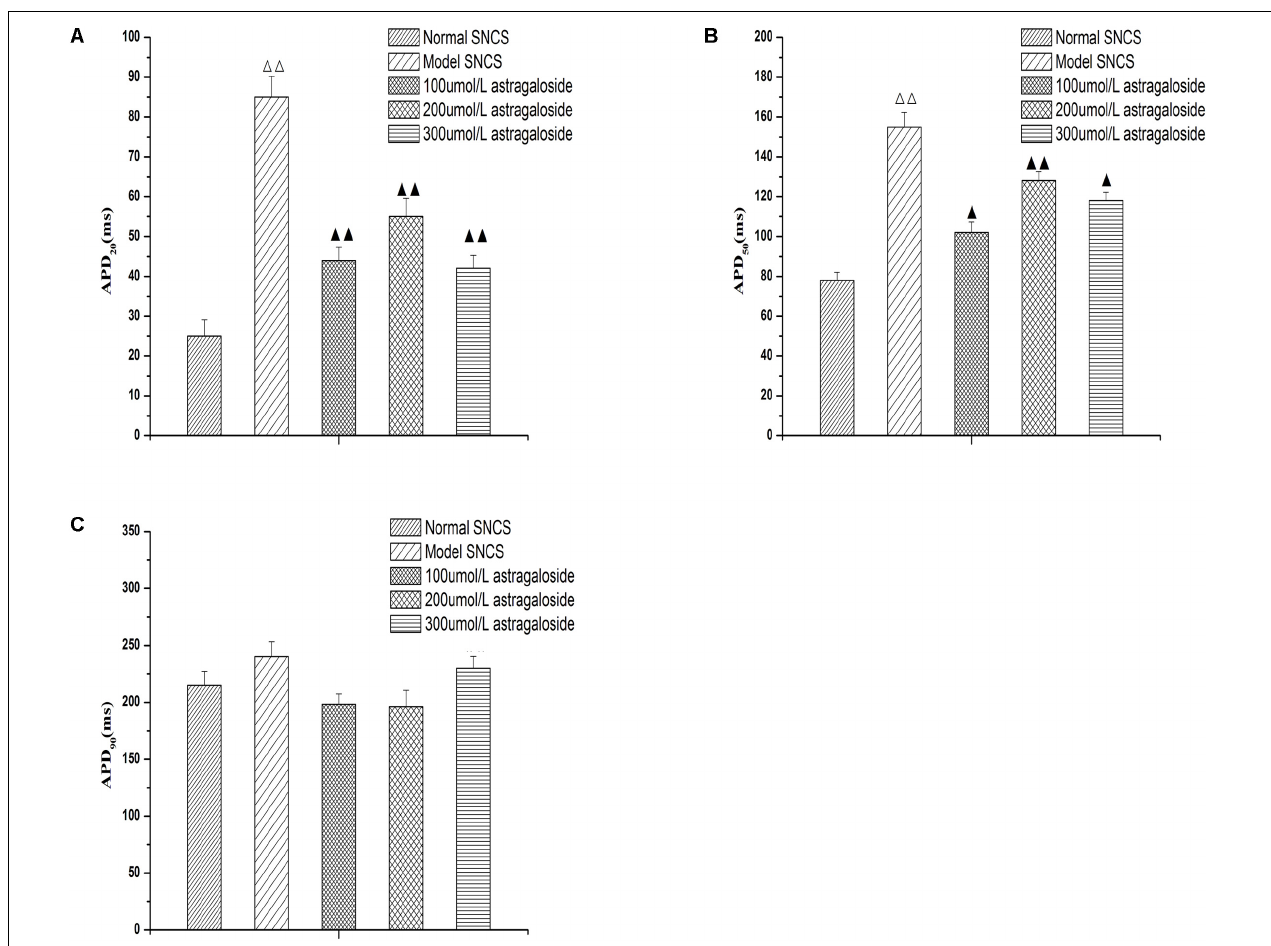
FIGURE 2 | (A) Effect of astragaloside on the APD20 in the damaged SAN cells of neonatal rabbits. (B) Effect of astragaloside on the APD50 in the damaged SAN cells of neonatal rabbits. (C) Effect of astragaloside on the APD90 in the damaged SAN cells of neonatal rabbits. n = 10, (cid:49)(cid:49) P < 0.01 vs. SAN cells; (cid:78)(cid:78) P < 0.01, (cid:78) P < 0.05 vs. SAN cells after establishment of the